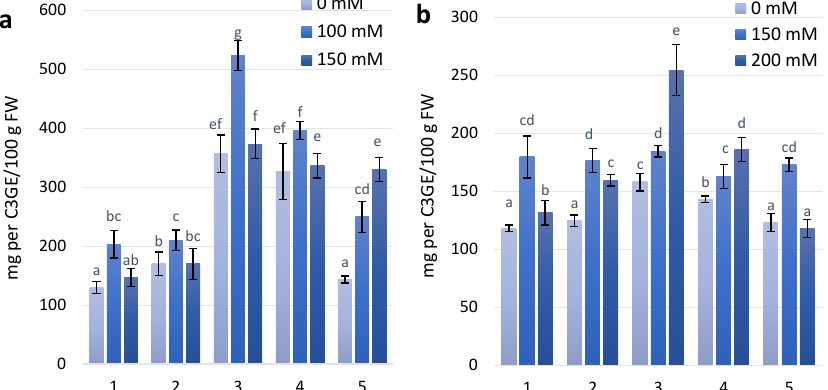
Figure 3. Anthocyanins content in wheat leaves under effect of different NaCl concentrations ( a )—first stage of treatment; ( b )—second stage of treatment. Wheat genotypes: 1—Citrus yellow, 2—KM 53-14 Blue, 3—KM 178-14 purple, 4—Skorpion Blue aleurone, 5—PS Karkulka purple. The columns represent the mean values ± S.E. for six replicates. Statistically significant differences among treatments at each time are indicated by different small letters (Duncan test, p < 0.05).